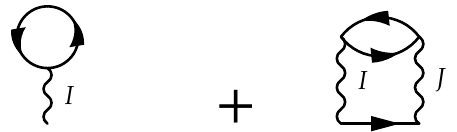
Figure 25. The diagrams for the first and second-order self-energy of the Hubbatr model labeled in real space. The indices I , J indicate sites in the real-space cluster, while the lines are Hartree-corrected propagators ˜ G